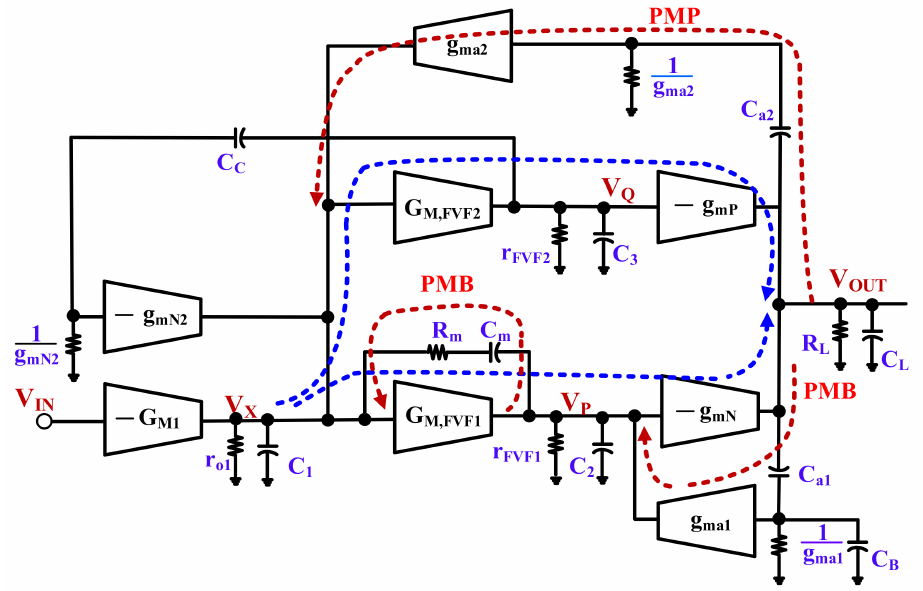
Figure 4. The detailed equivalent small signal model of the proposed DLAFC in this work.